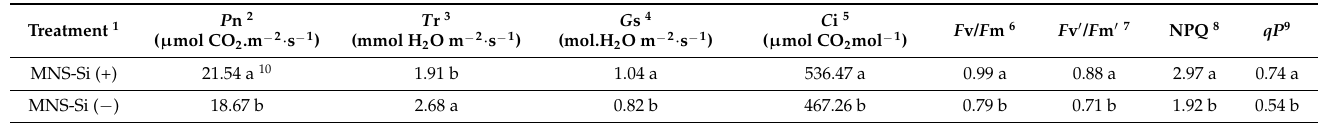
Figure 6. Effect of 30 days of silicon application on chlorophyll content in the coffee plants grown in plant growth chambers. Si (+) and Si ( − ) refer to 75 and 0 mg · L − 1 , respectively. Vertical bars indicate the means ± standard error ( n = 6). Different lowercase letters indicate the significant separation within treatments by the Duncan’s multiple range test at p ≤ 0.05. Table 2. Influence of 30 days of silicon application on the photosynthetic and chlorophyll fluorescence characteristics of the coffee plants grown in plant growth chambers.